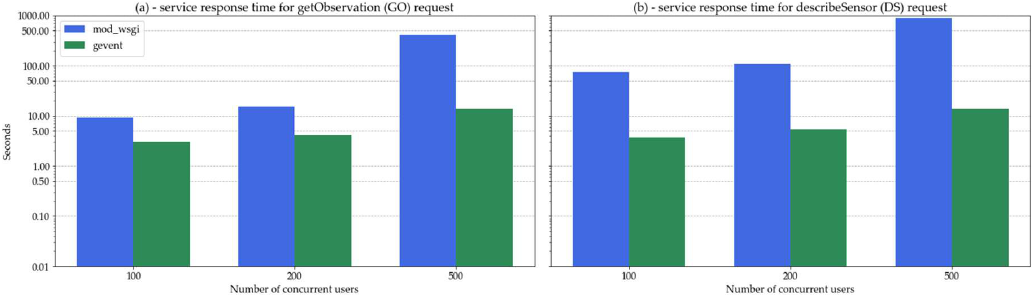
Figure 6. Service response time for the getObservation (a) and describeSensor (b) SOS requests in